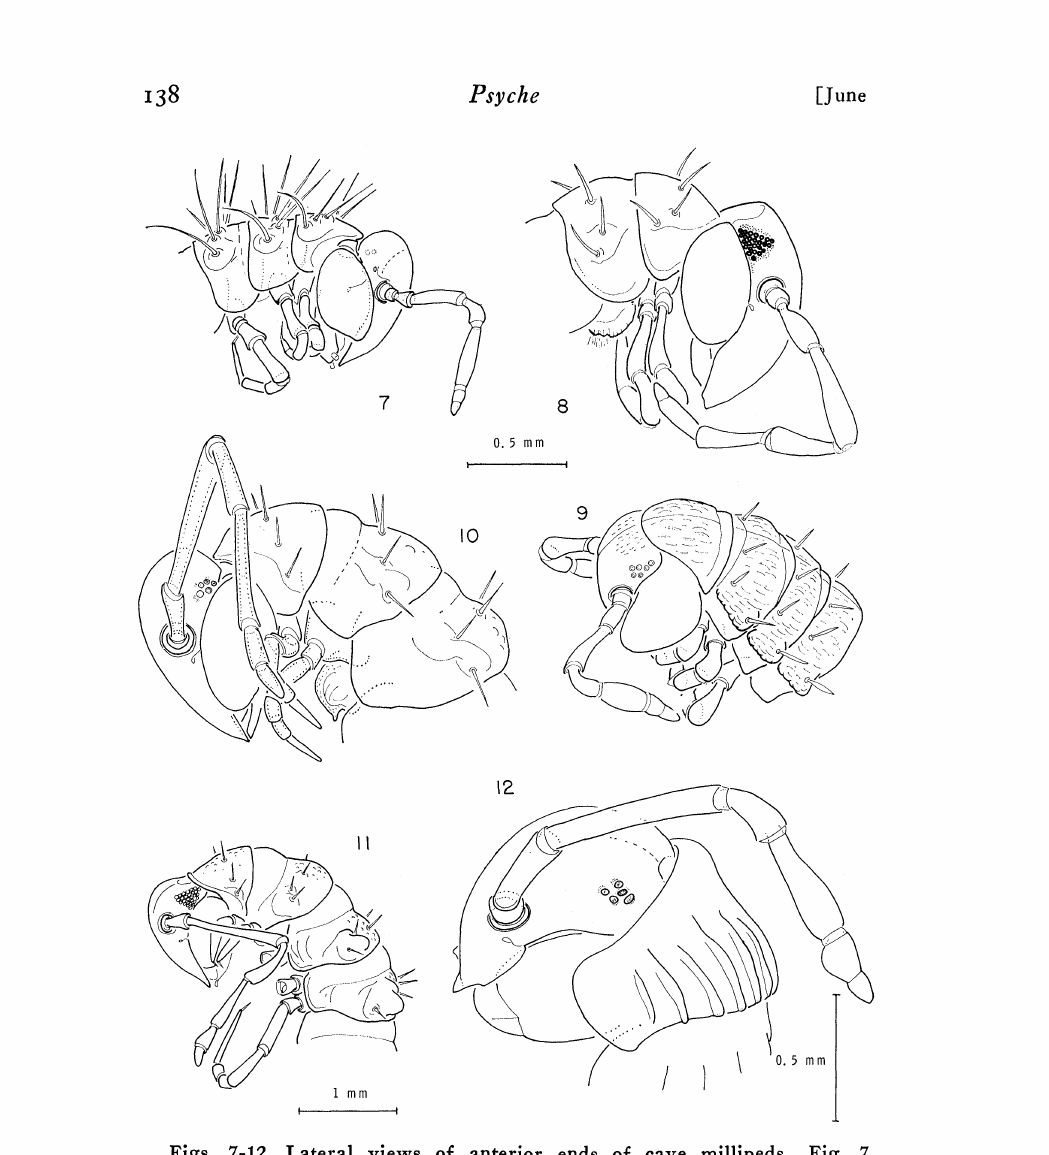
Figs. 7-12. Lateral views of anterior ends of cave millipeds. Fig. 7. Scoteres austrinus. Fig. 8. Conolyla bollmani. Fig. 9.Tingua allida. Fig. 10. Pseudolremia nodosa. Fig. 11. Pseudotremia hobbsi. Fig. 12. Seostriara